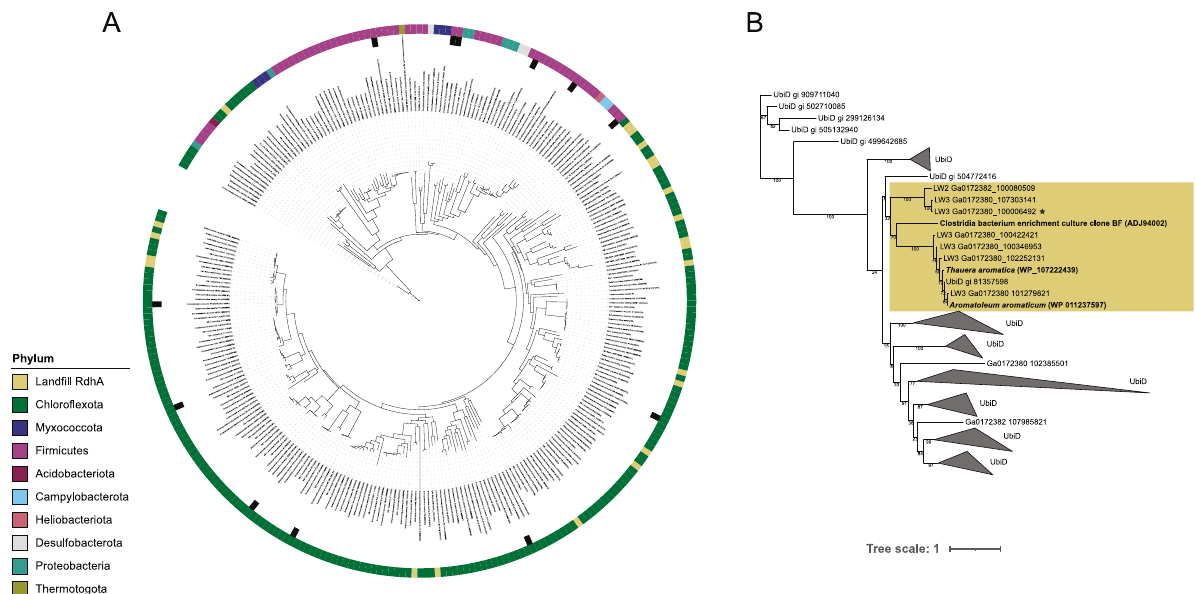
Fig. 6 Maximum likelihood trees placing land fi ll-derived reductive dehalogenases (RdhA) and anaerobic benzene decarboxylases (AbcA) within their respective gene families. A RdhA ML tree, with outer ring indicating phylum of origin for the RdhA and inner ring denoting the characterized RdhA with known substrates in black. Land fi ll sequences are highlighted in yellow. The tree was imaged using iTol [88] and the muted colour-blind friendly palette designed by Paul Tol. B AbcA ML tree with UbiD outgroup. AbcA clade is highlighted with yellow with reference sequences bolded; all collapsed clades are UbiD sequences exclusively. The AbcA sequence associated with a high quality MAG is starred. For both trees, bootstrap values are present as numeric values on the